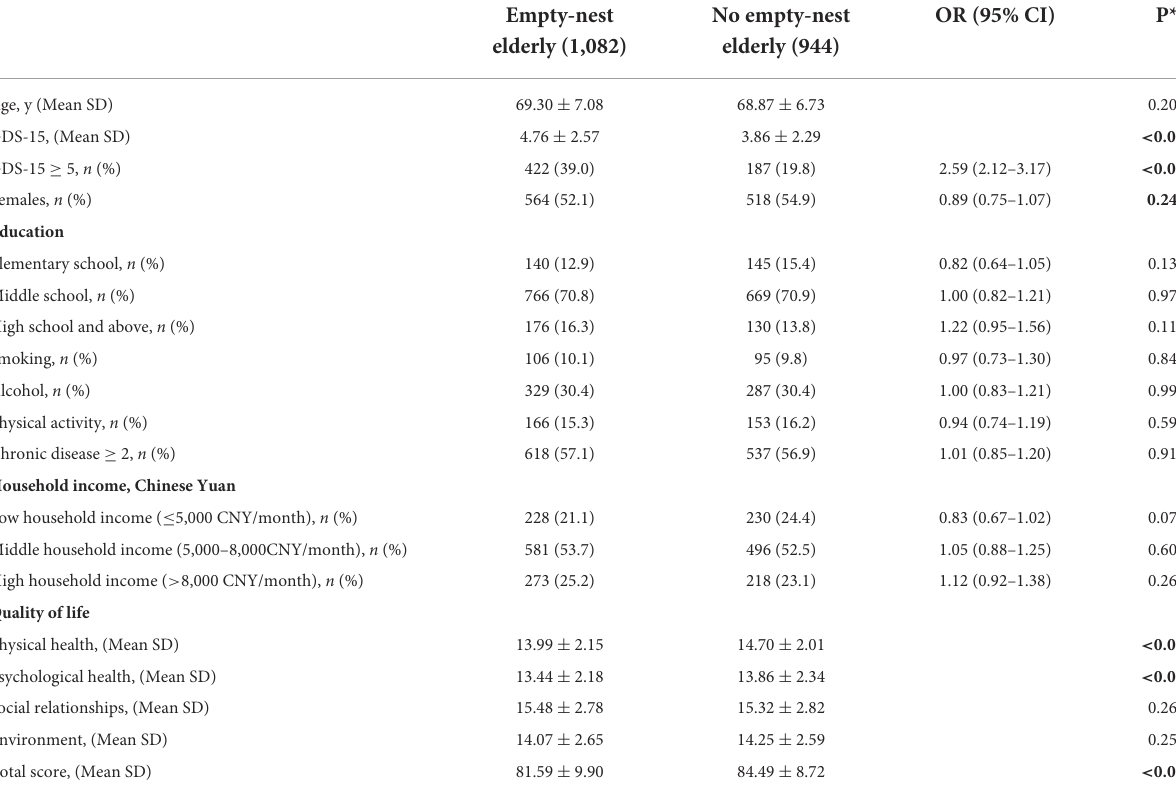
TABLE 1 Comparison of baseline characteristics between empty-nest elderly and no empty-nest elderly groups.